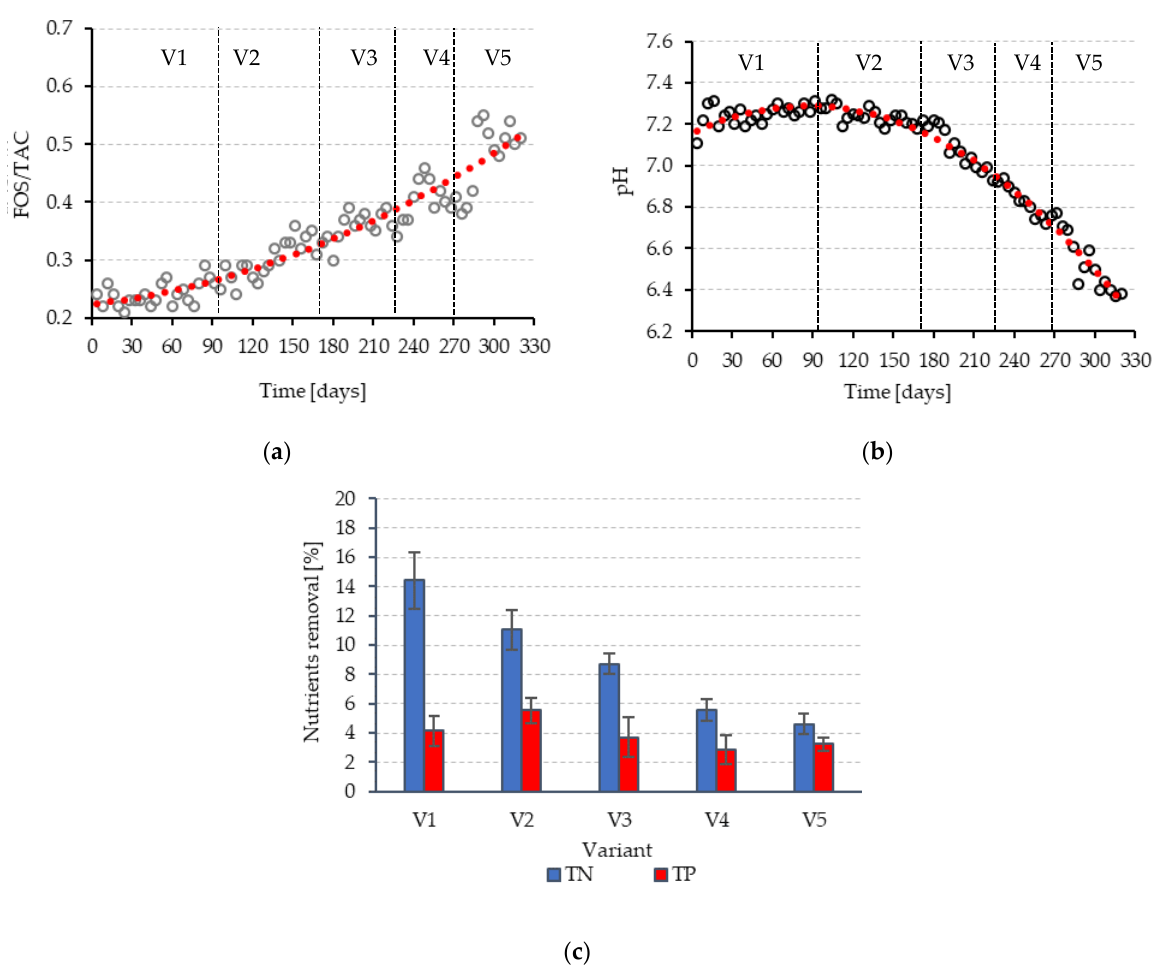
Figure 3. The efficiency of anaerobic dairy treatment in stage 1: ( a ) FOS/TAC ratio in the methano- genesis tank during the experimental time (variants V1–V5); ( b ) pH in the methanogenesis tank during the experimental time (variants V1–V5); ( c ) nutrient removal (nitrogen and phosphorus) with a standard deviation in experimental variants V1–V5.